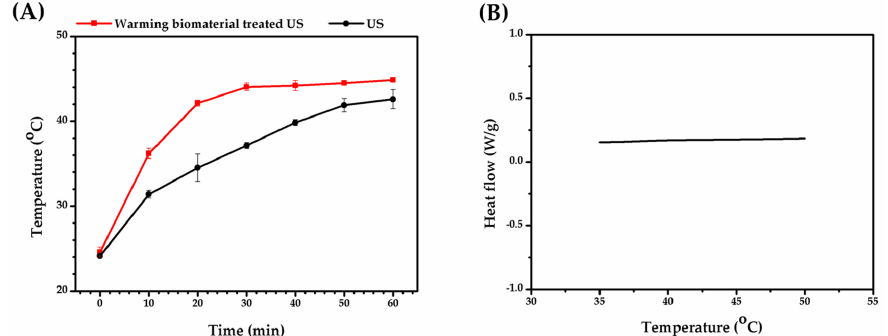
Figure 1. Morphology of biomaterials longitudinal sections by scanning electron microscope. ( A ) PCL membrane, and ( B ) warming biomaterial. White arrows indicate magnetic nanoparticles and black arrows indicate pores of biomaterials.